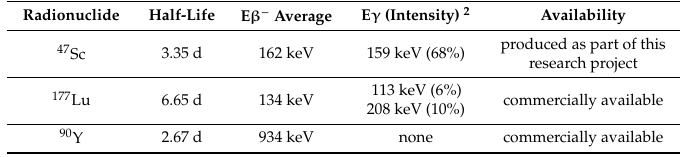
Table 1. Decay properties 1 of the therapeutic radionuclides, 47 Sc, 177 Lu, and 90